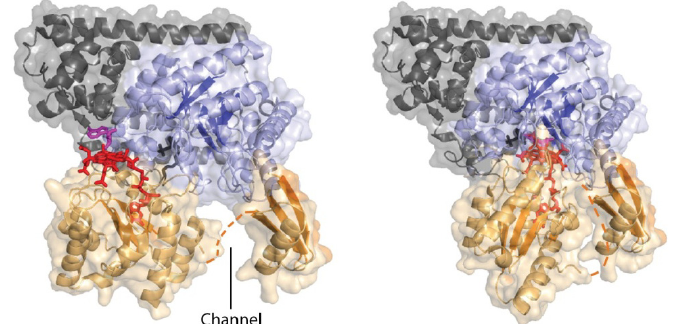
Figure 4. Models of closed conformations of ( top ) 5,6-LAM and ( bottom )